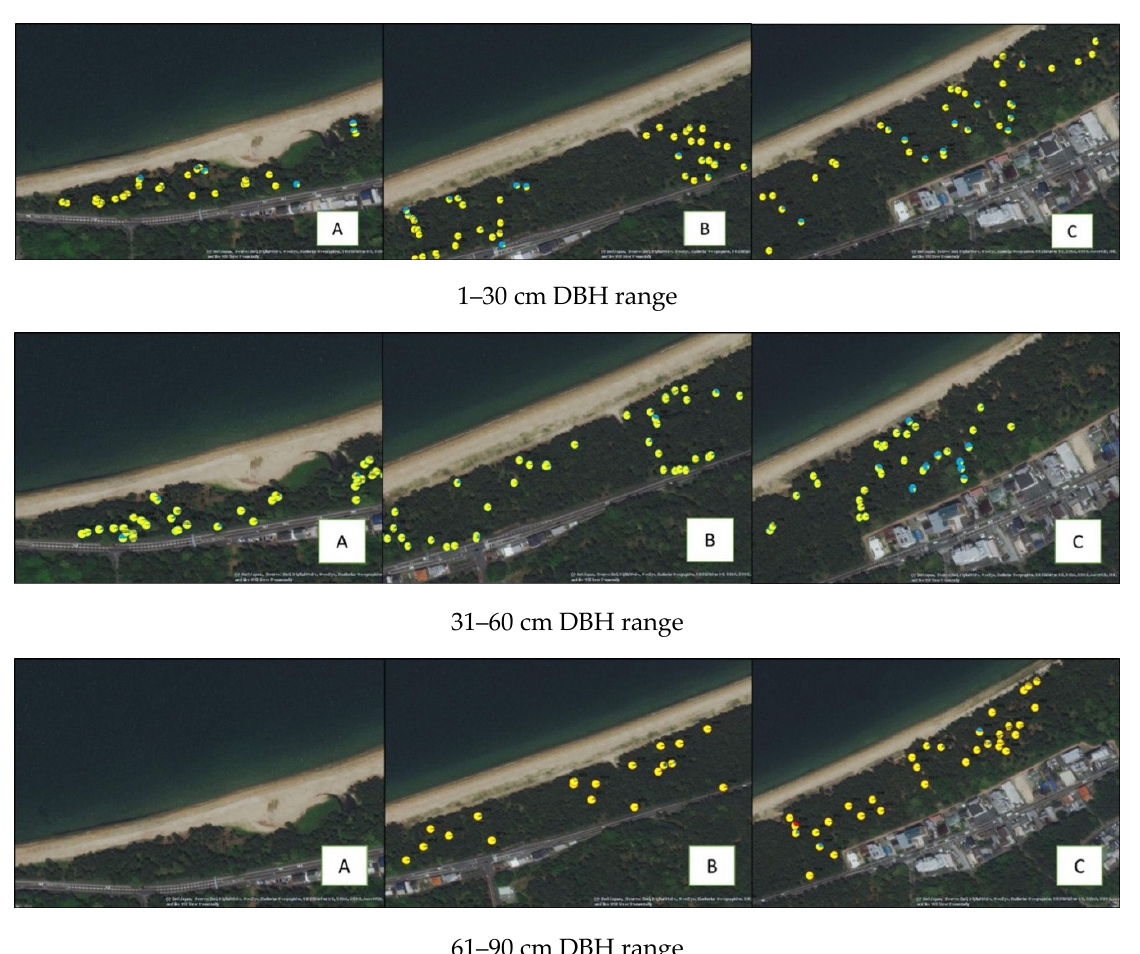
Forests 2021 , 12 , x FOR PEER REVIEW Figure A1. Genetic structure of Iki-no-Matsubara (Fukuoka) with 42 old populations of P.thunbergii on K 2, K 3, and K 4 (From South-West ( Left ) to North-East ( Right )).